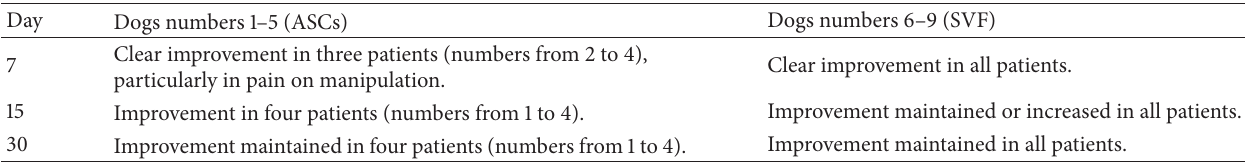
Table 2: Clinical outcomes regarding range of motion, lameness, and pain on manipulation on days 7, 15, and 30 after treatment with adipose- derived stem cells (ASCs, dogs numbers from 1 to 5) or autologous stromal vascular fraction (SVF, dogs numbers from 6 to